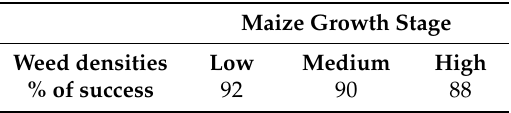
Table 5. Percentage of success for weeds detection for three (low, medium, high) maize growth stages.